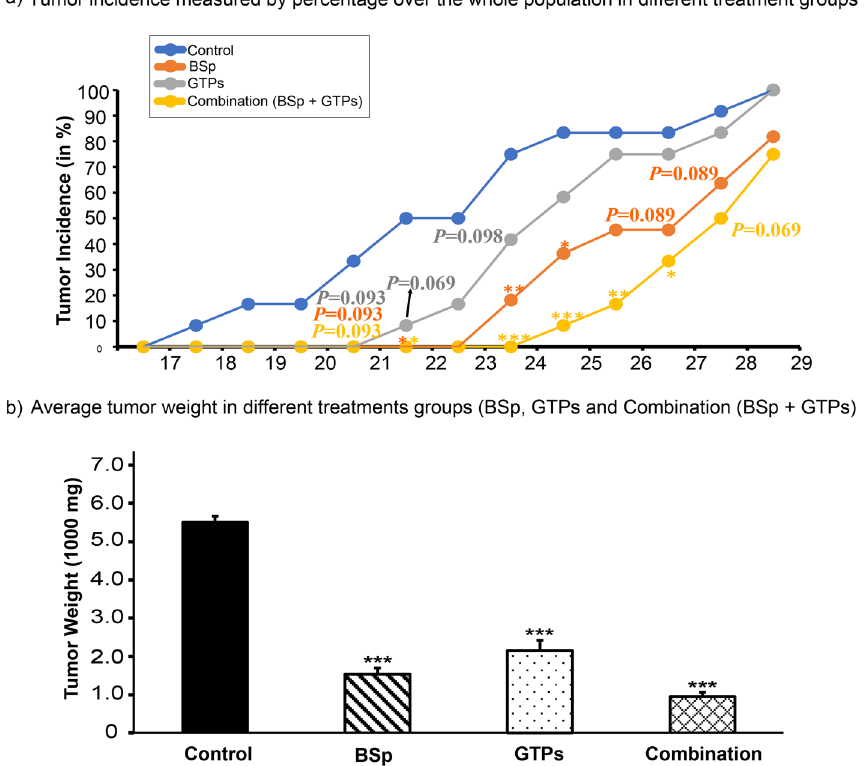
Figure 1. Her2/neu mice were administered with regular control diet, 26% BSp diet, 0.5% GTPs in drinking water or BSp and GTP in combination (BSp + GTPs) upon weaning at 3 weeks. Dietary treatment continued throughout the study until termination of the experiment and mice were evaluated for tumor growth weekly. ( a ) Tumor incidence measured by percentage over the whole population. ( b ) Average tumor weight among BSp, GTPs and the combination treatment group. Columns represents mean; bars, standard error; *p value < 0.05, **p value < 0.01, ***p value < 0.001 which were significantly different from the control